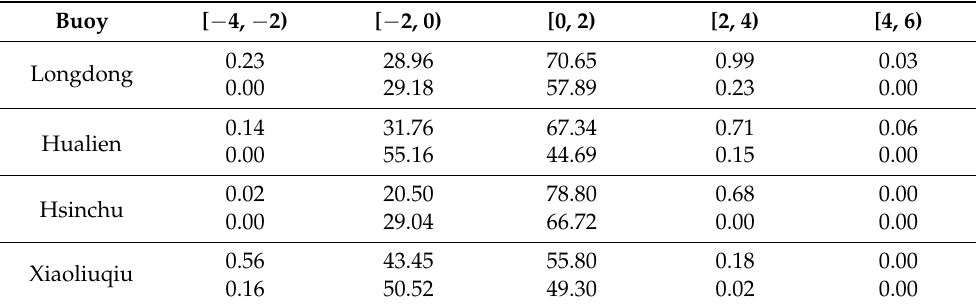
Table 1. Percentages of the model-data differences (units of meters) for the SWH at different classes and buoys using winds from CFSR (upper) and CFSR_5km (lower).